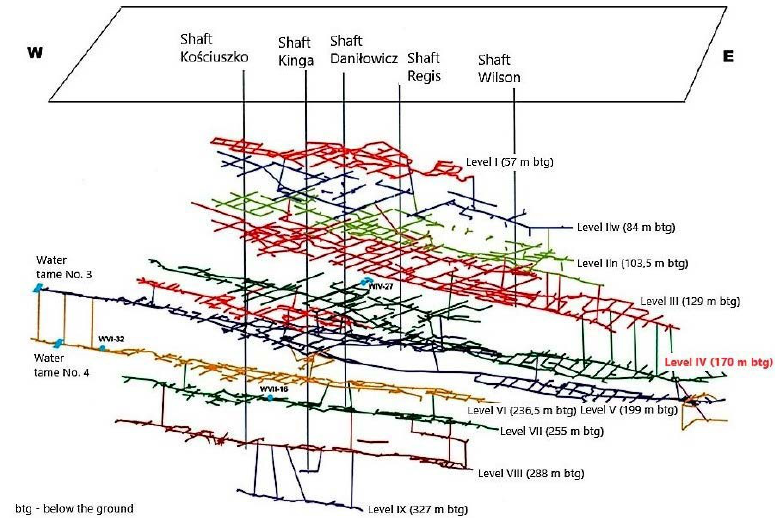
Figure 1. A simplified diagram of the workings of the “Wieliczka” Salt Mine.